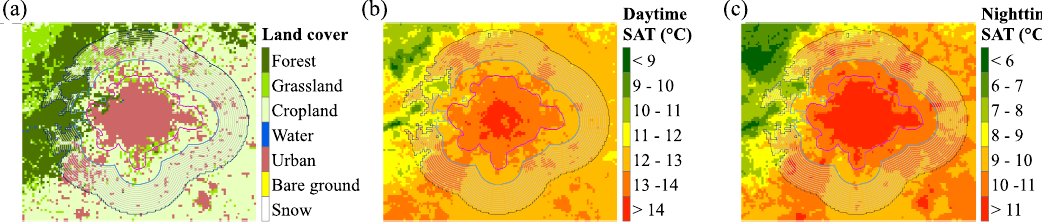
Figure 3. Beijing area maps of ( a ) Moderate Resolution Imaging Spectroradiometer (MODIS) land cover/use data, annual; ( b ) daytime (14:00); and ( c ) nighttime (02:00) surface air temperature in 2009. The pink, blue, and mazarine lines denote the borders of Beijing’s urban areas, suburban areas of the same size as urban areas, and outer suburbs with 15 km buffer distance measured outwards from suburb to outer suburb, respectively. Grey lines are equally spaced lines between suburban areas and the outer suburbs plotted at 1-km intervals.